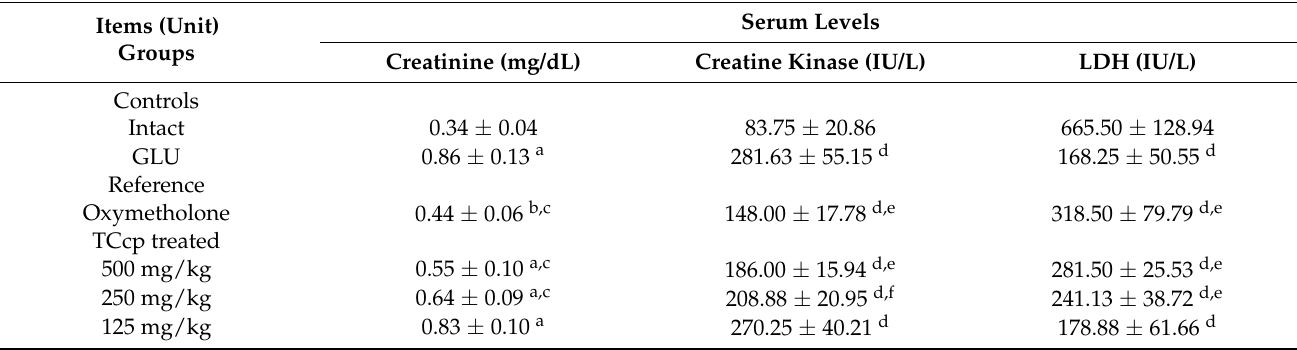
Table 3. Changes in the serum